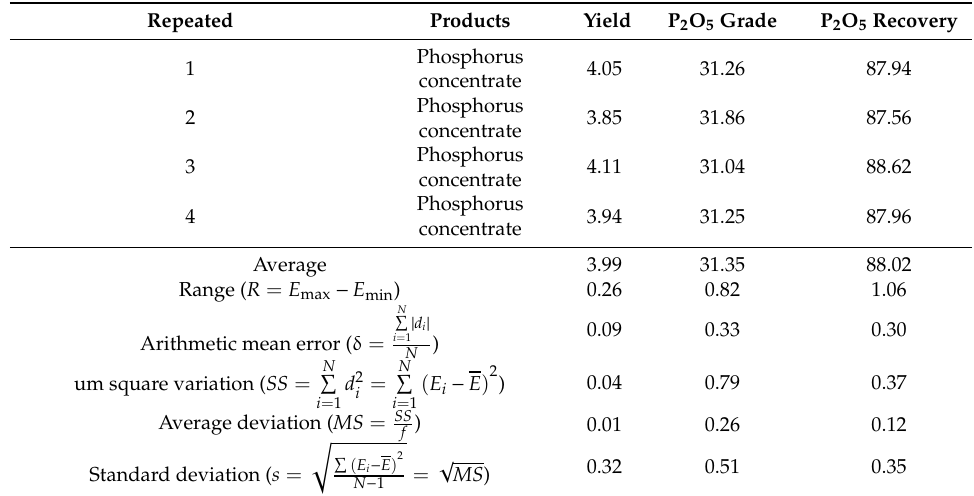
Table 5. Results of the whole flotation test flowsheet of recovering phosphorus (%).